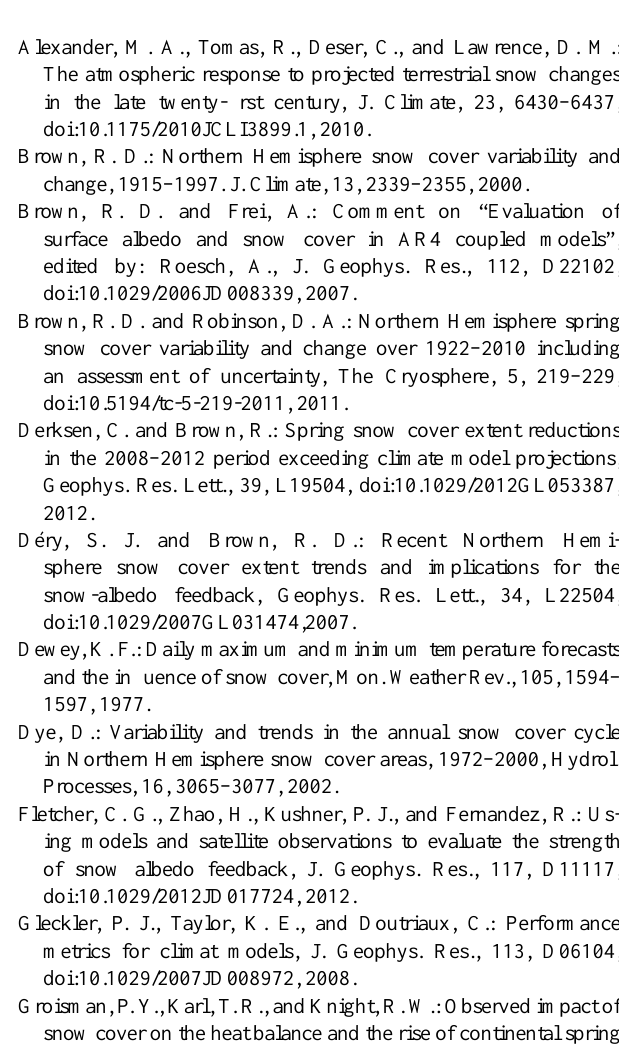
Fig. 9. NH ice-free land spring (March–April) SCE (relative to 1986–2005) as a function of global mean annual mean surface air temperature (relative to 1986–2005), for the historical runs and the scenario runs until 2100. (a) For CCSM4 (4 RCP and historical ensemble means); (b) for all models, RCP8.5 until 2100 and historical ensembles only. The data shown are 5-yr running averages.